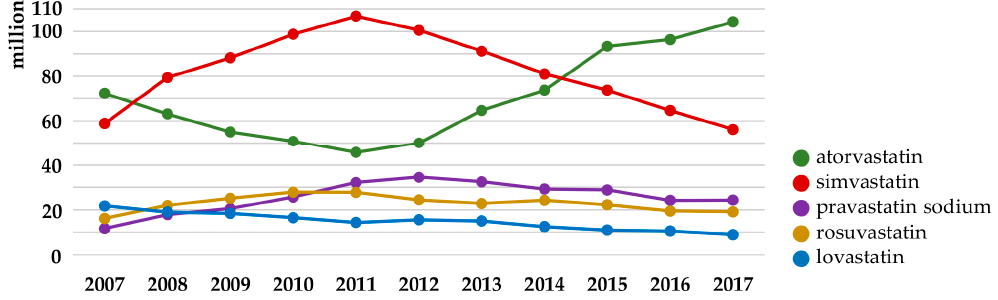
Figure 3. The number of prescriptions of statins in the United States in the period 2007 to 2017 (source: https://clincalc.com; accessed on 19 September 2020).